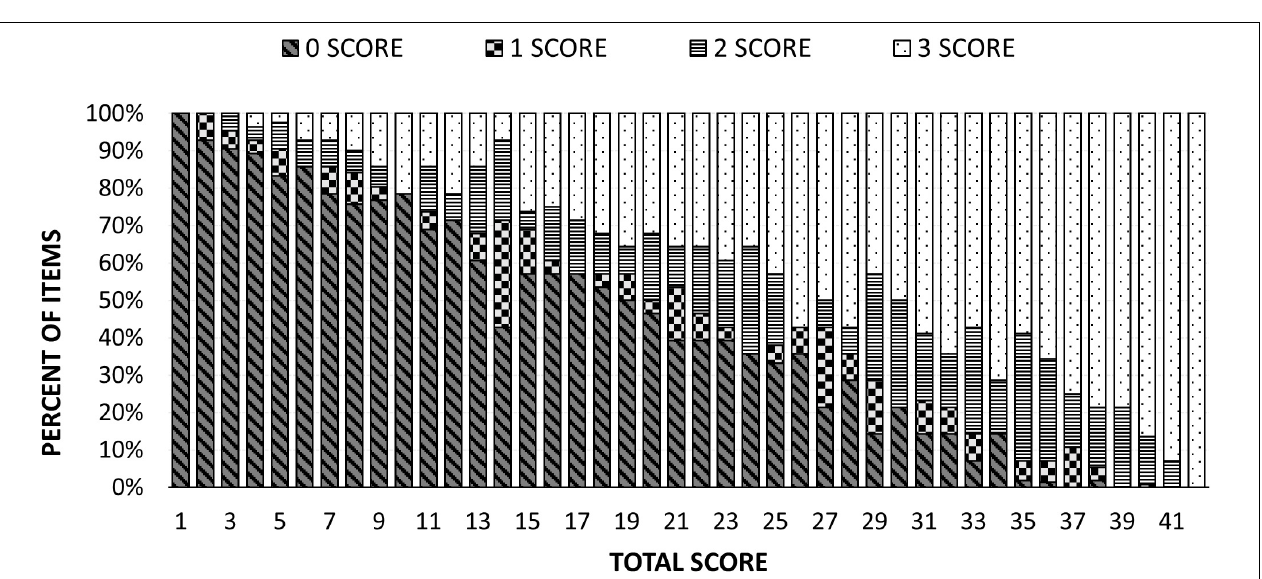
FIGURE 4 | Cumulative bar plot showing pooled frequency of 0, 1, 2, and 3 item scores as a function of total score.